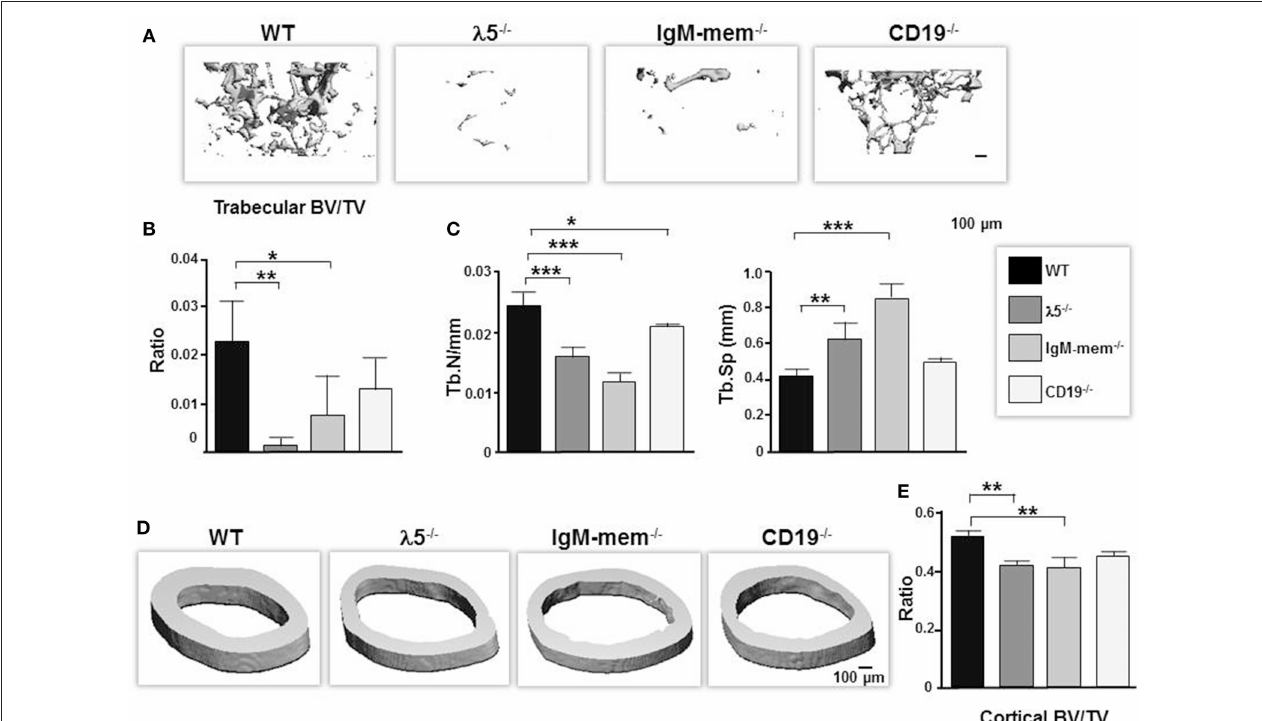
FIGURE 1 | Deficiencies in preBCR formation and functional activity result in loss of cortical and trabecular bone mass. Representative µ CT images of femurs from the indicated 6-month old WT and homozygous λ 5 − / − , IgM-mem − / − , and CD19 − / − C57BL/6 mice. (A) Representative 3D reconstructions of trabecular